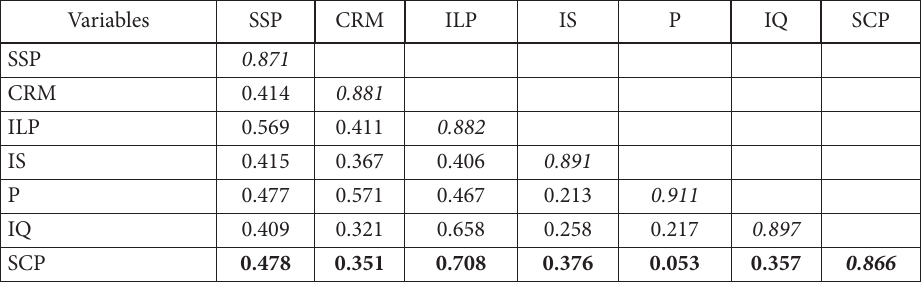
Table 2. Fornell and Larcker’s analysis